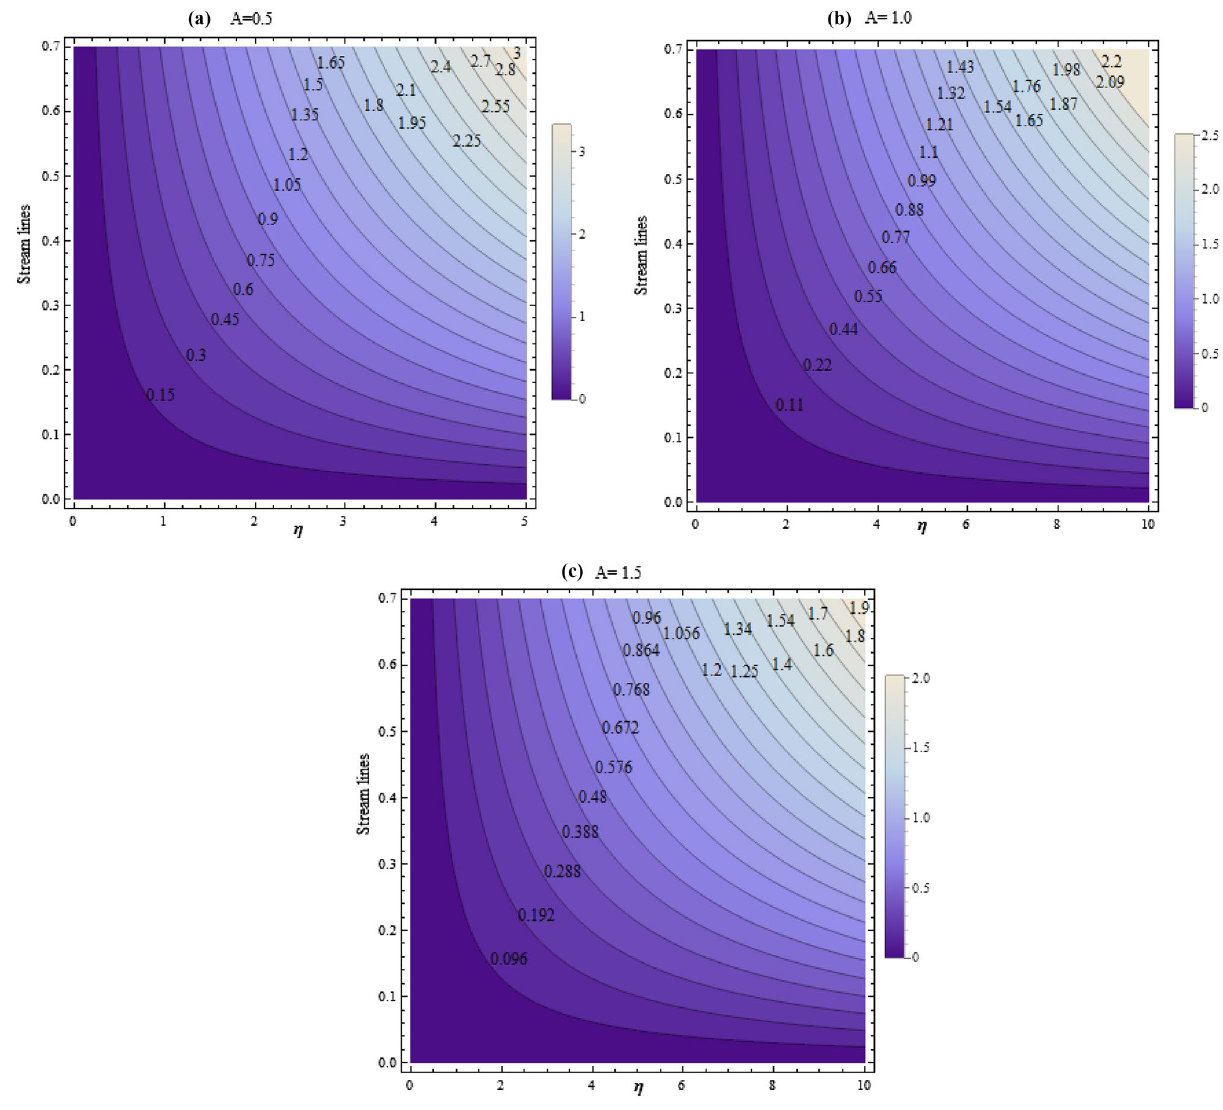
Figure 16. Streamlines for numerous values of